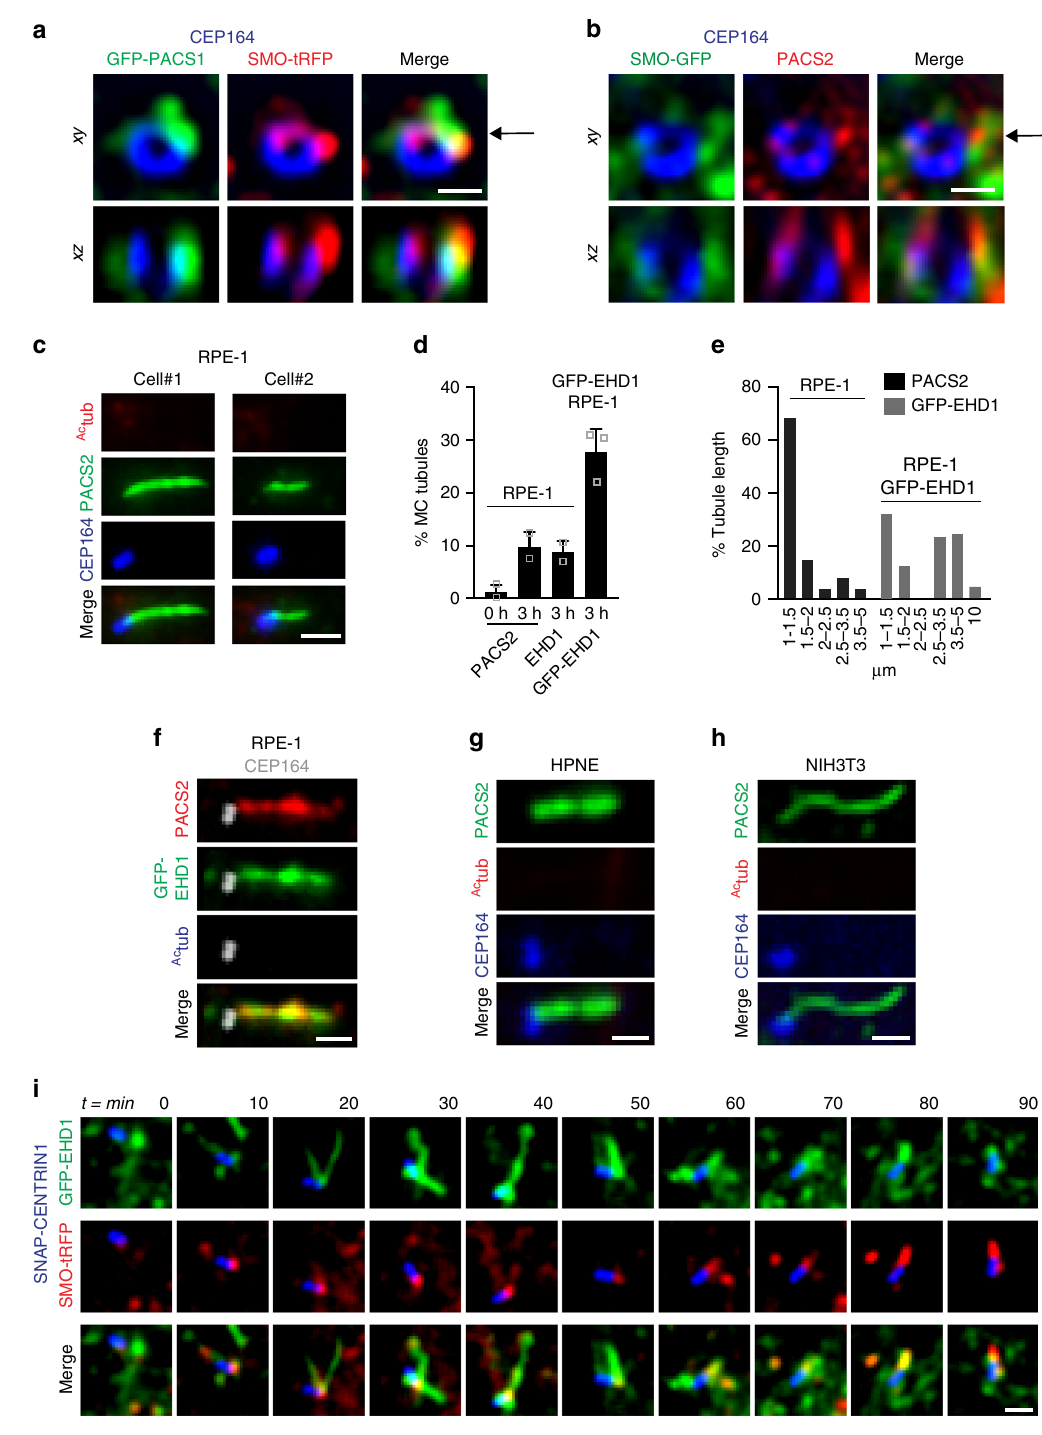
Smooth function was applied using ImageJ to some images as indicated in fi gure legend. Structural illumination microscopy (SIM) . Coverglasses (no. 1.5) with fi xed cells incubated with 100 nm Tetra Speck beads (Life Technologies) in the fi nal wash were mounted onto glass slides with Vectashield H-1000 (Vector) and sealed with nail polish. All 3D-SIM imaging was performed using a Nikon N-SIM (Nikon Instruments, Melville, NY) or a Zeiss SIM (Carl Zeiss Microscopy, LLC, Peabody, MA) microscope as speci fi ed in fi gure legend. Nikon SIM images were taken with a SR Apo TIRF ×100/1.49 NA oil immersion objective (Nikon) and EMCCD camera (Andor DU-897E) and Zeiss SIM images were taken with a 63 ×1.4 NA oil objective (Zeiss) and a PCO edge sCMOS camera as described previously 8 . Brie fl y,